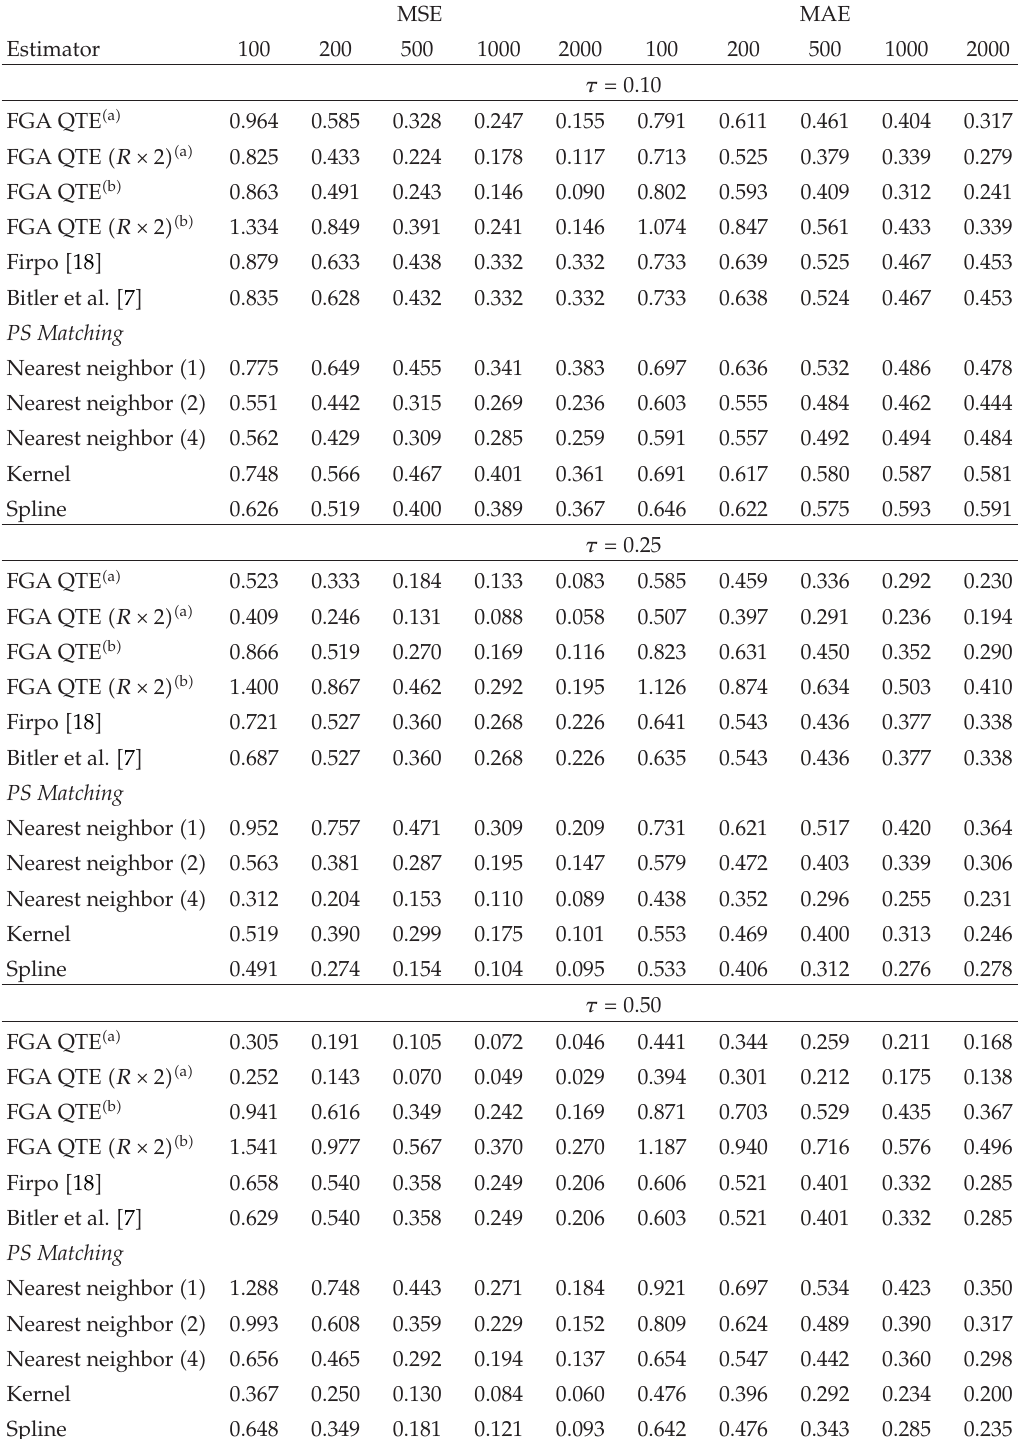
Table 2: QTE Monte Carlo